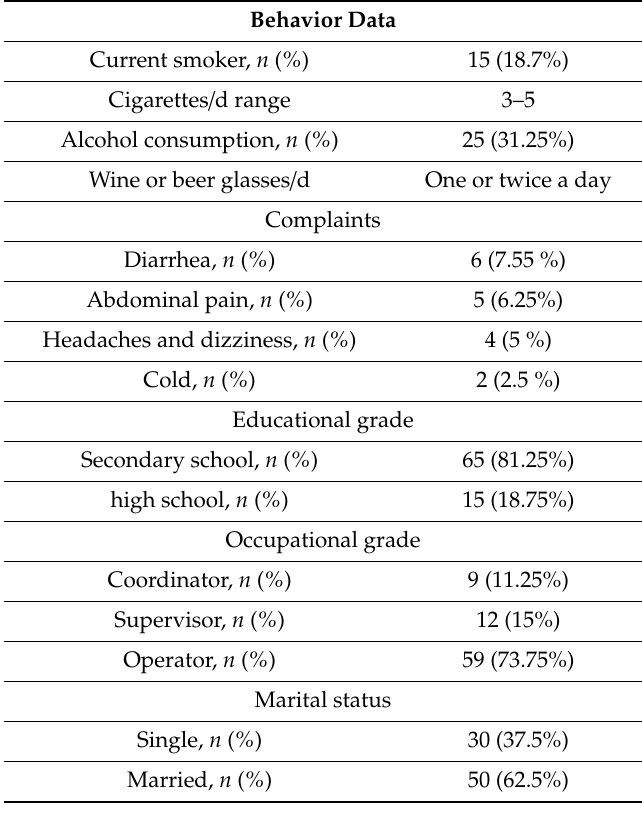
Table 3. Characteristics of enrolled gas and oilfield